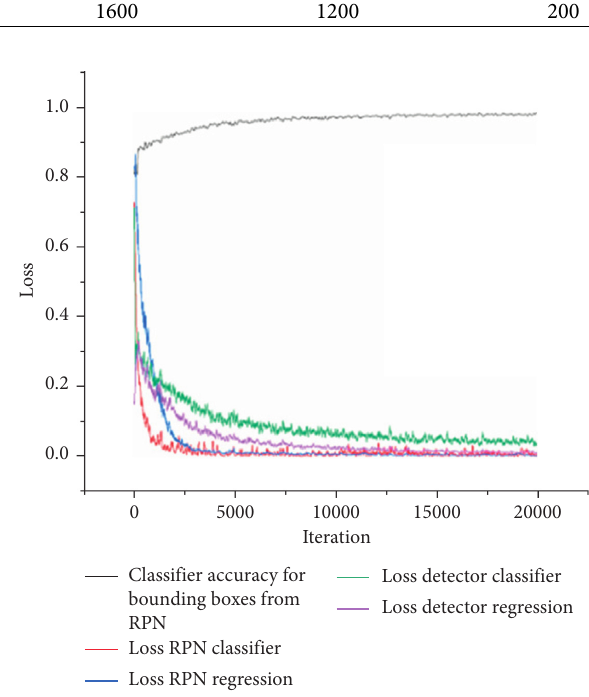
Figure 15: The loss-iterations curves of target recognition